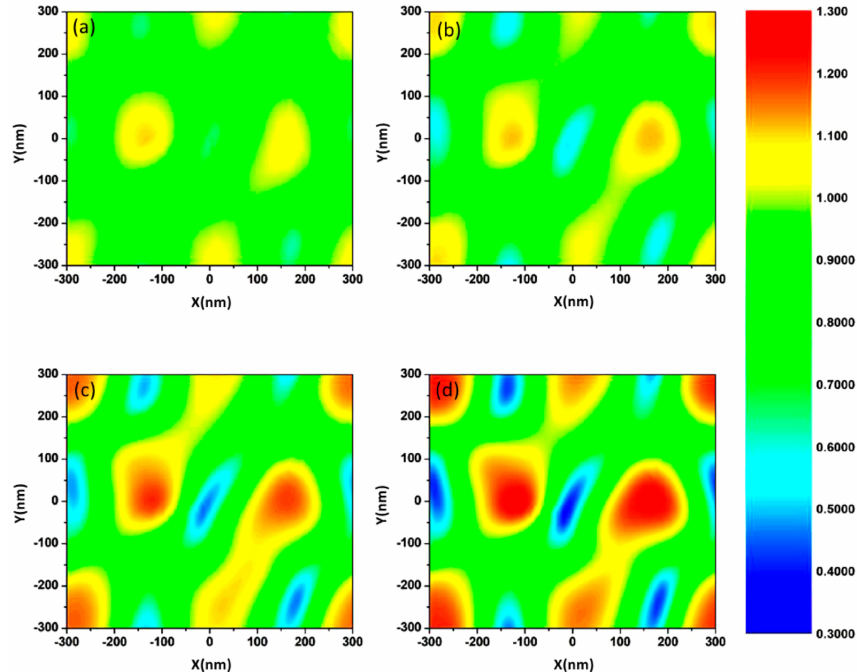
Figure 7. FDTD simulation patterns of electric field amplitude for ITO films: ( a ) S0, ( b ) S1, ( c ) S3, and ( d )